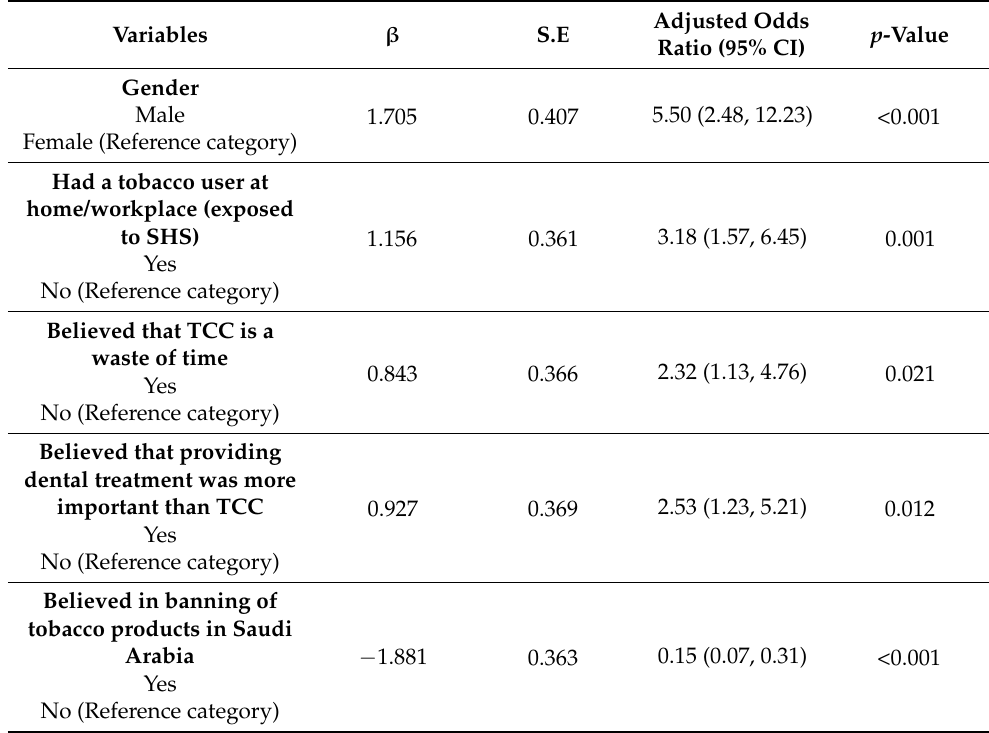
Table 3. Multiple logistic regression final model. Tobacco use among dental professionals and its relationship with study